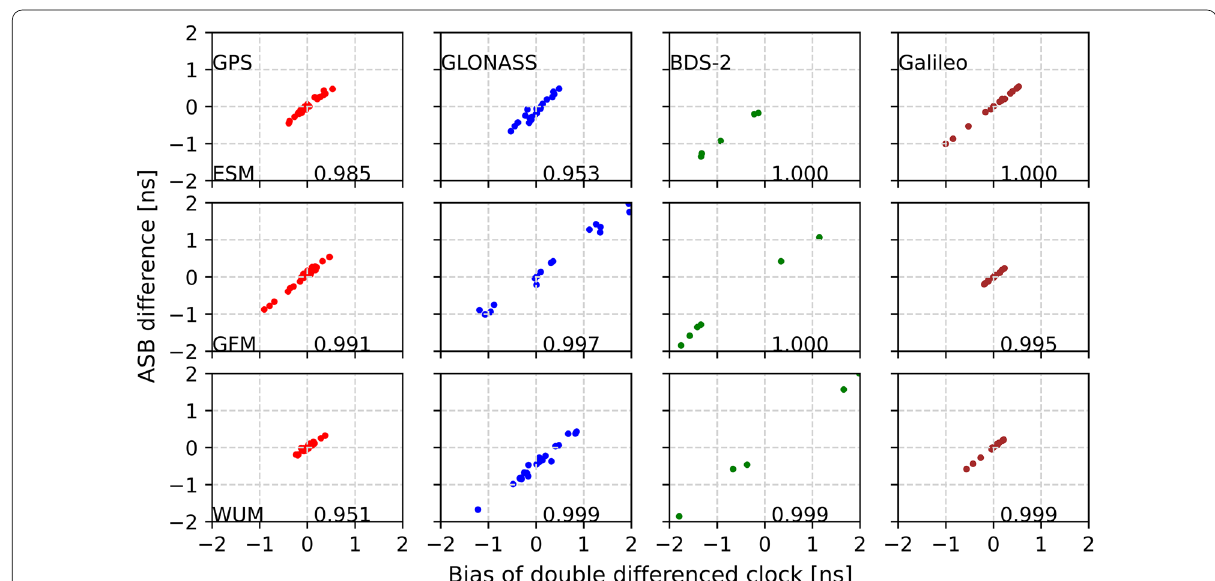
Fig. 3 Correlations between the bias of double differenced clock and ASB for satellites of each constellation with respect to COM on DOY 001, 2018. The values in black are the correlation